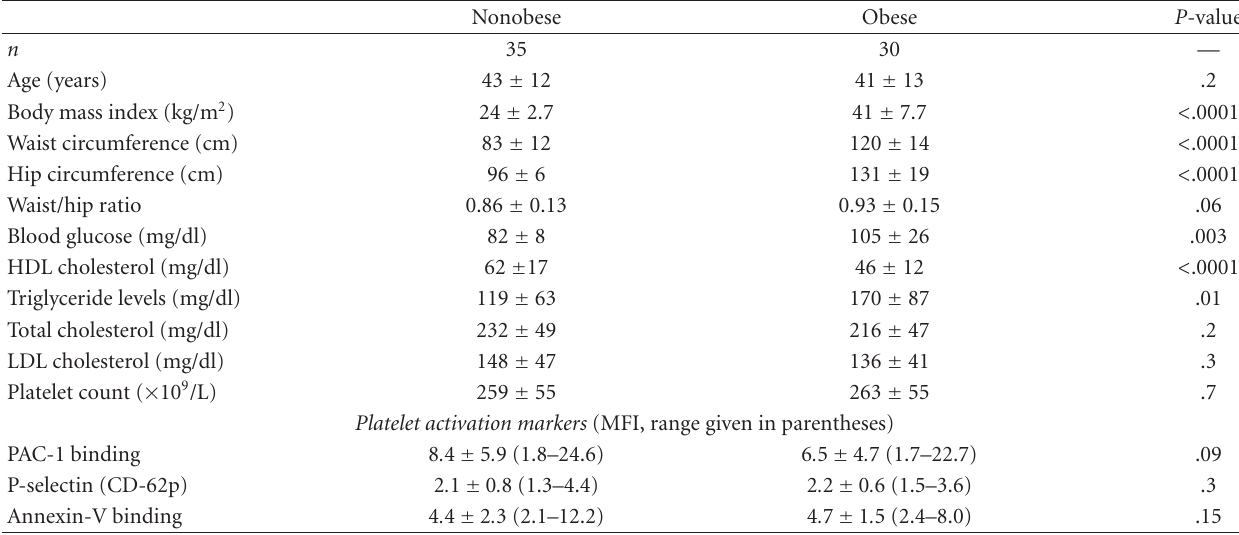
Table 4: Clinical data, laboratory findings, and platelet activation markers for subjects in the platelet activation